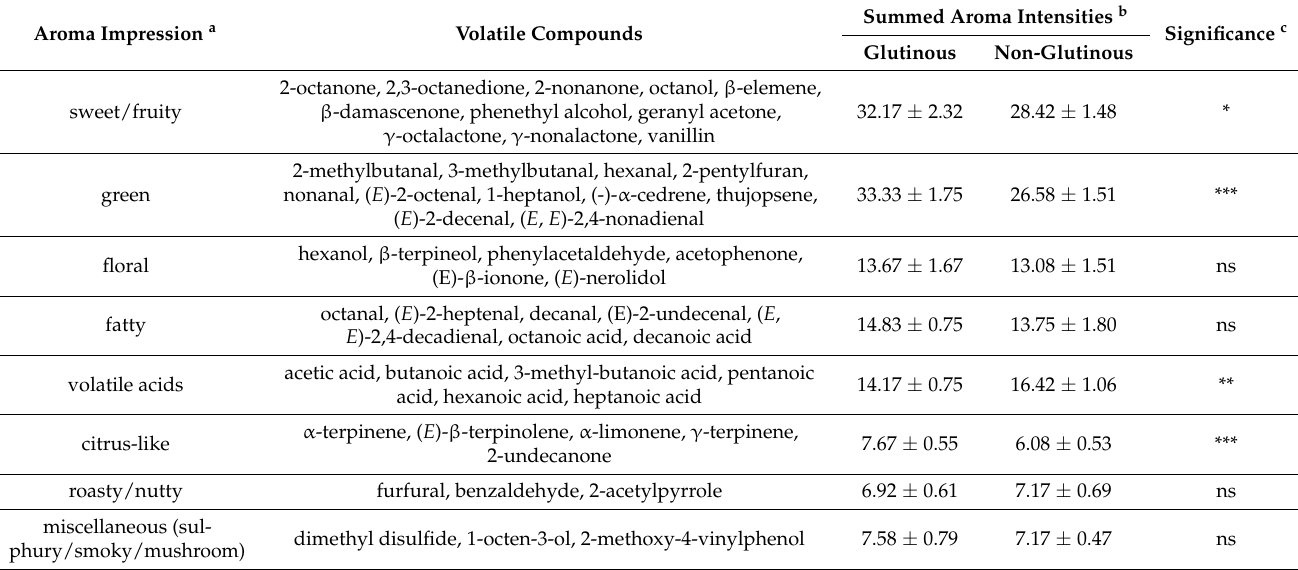
Figure 4. ( A ) Gas chromatography-mass spectrometry (GC-MS) and ( B ) gas chromatography-olfactory (GC-O) chromatograms of cooked glutinous sorghum. Numbers correspond to the compounds listed in Table 3. Table 4. Summed aroma intensities of each aroma group present in the cooked glutinous and non-glutinous sorghum